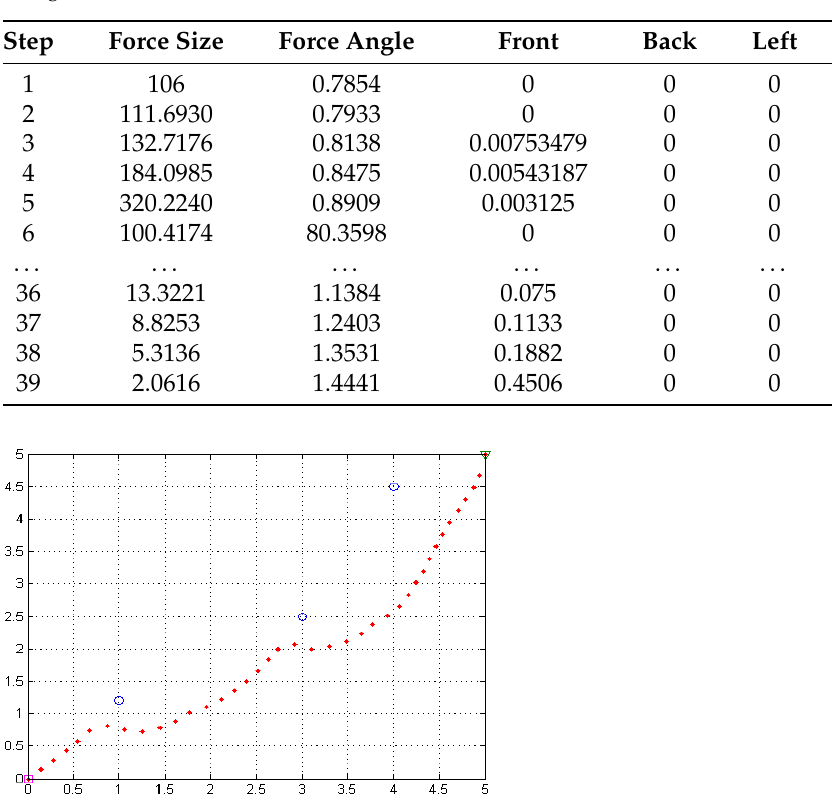
Figure 7. The successfully planned path in MATLAB corresponds to Table 1. The three blue circles in the figure are obstacles, and the red dots are the successfully planned